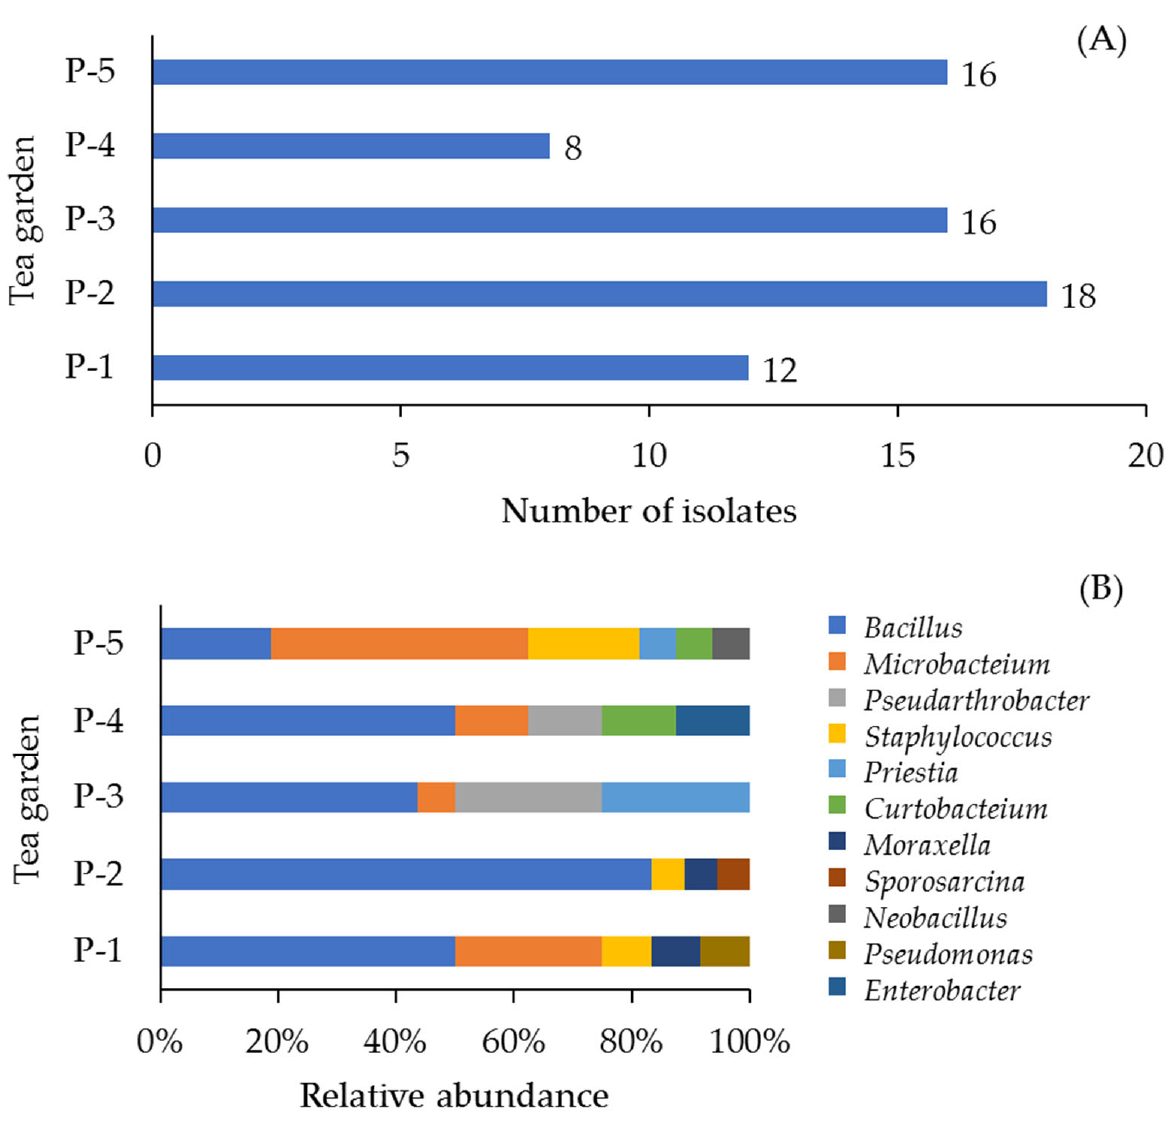
Figure 2. Number of endophytic bacterial isolates ( A ) and percent relative abundance of endophytic bacterial genera ( B ) found in each of five different tea gardens of Chiang Mai province.